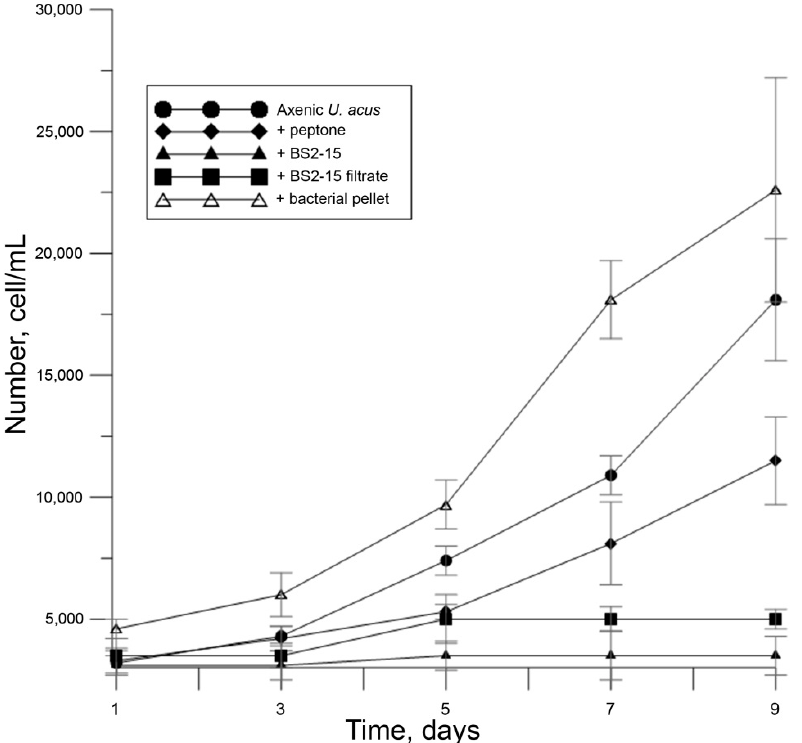
Figure 4. Growth of U. acus BK280 during inoculation with 1% peptone solution (100 μ L/mL), B. mycoides BS2-15 bacterial culture (100 μ L/mL), bacterial filtrates (100 μ L/mL) and bacterial pellet (bacterial culture washed from the 1% peptone solution, 100 μ L/mL).